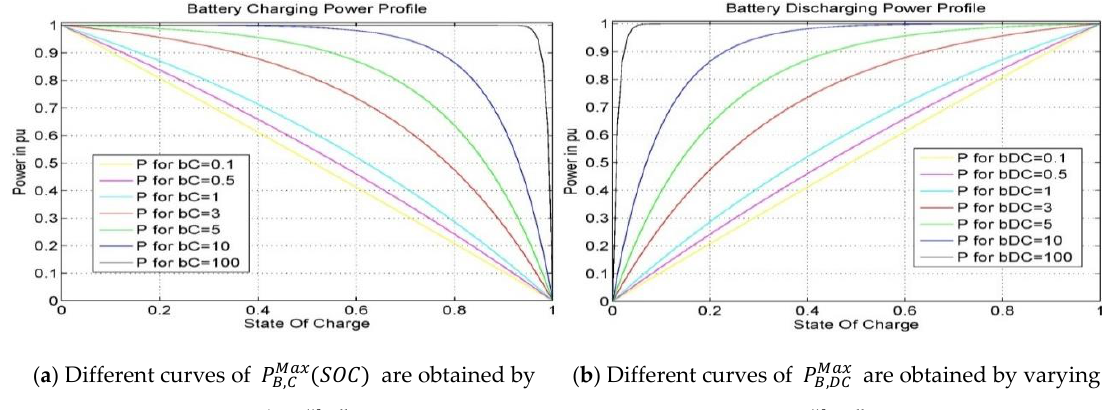
( b ) Different curves of 𝑃 𝐵,𝐷𝐶𝑀𝑎𝑥 are obtained by varying “ 𝑏 𝐷𝐶 ” Figure 3. Different charging ( a ) and discharging ( b ) power profiles using Equations (10) and (11).